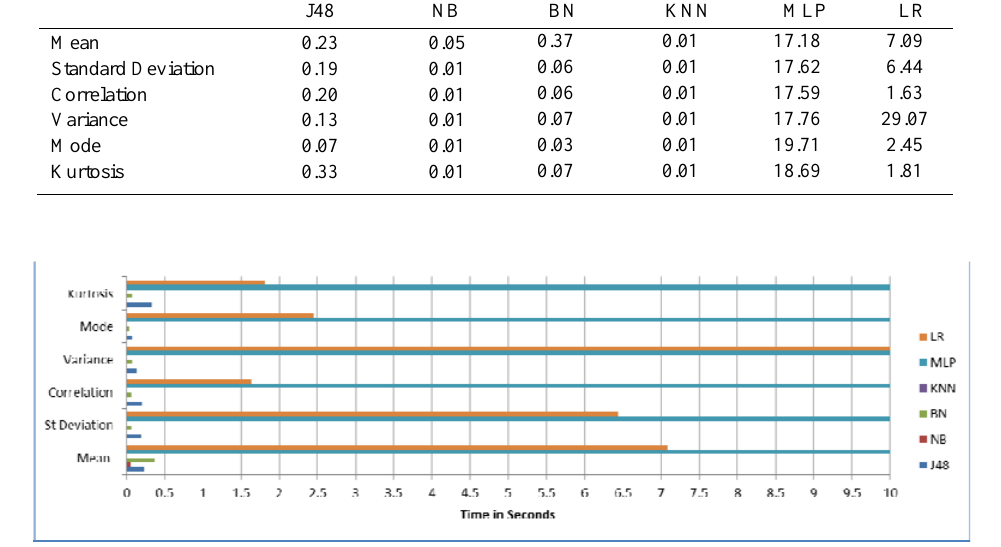
Table 5. Time taken to build classification model – algorithm vs. algorithm (time in seconds).